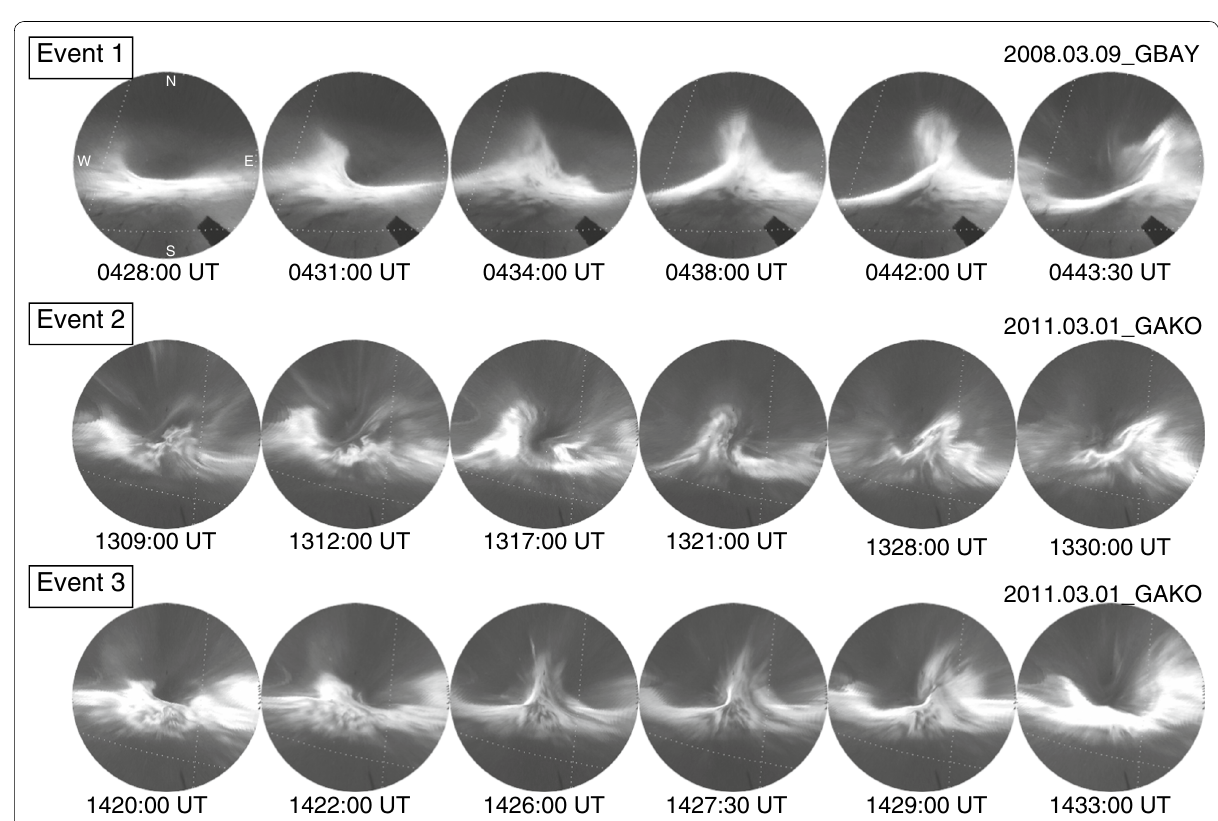
Fig. 7 Images of three events from the growth period to the declining period through the maximum